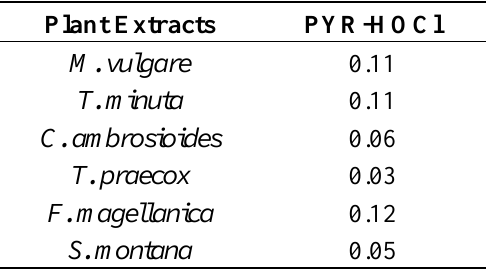
Table 2. PYR-HOCl values (relative to gallic acid activity) of plant extracts. Data represent the mean of at least three independent experiments. Standard deviation (SD) represented less than 10% of the